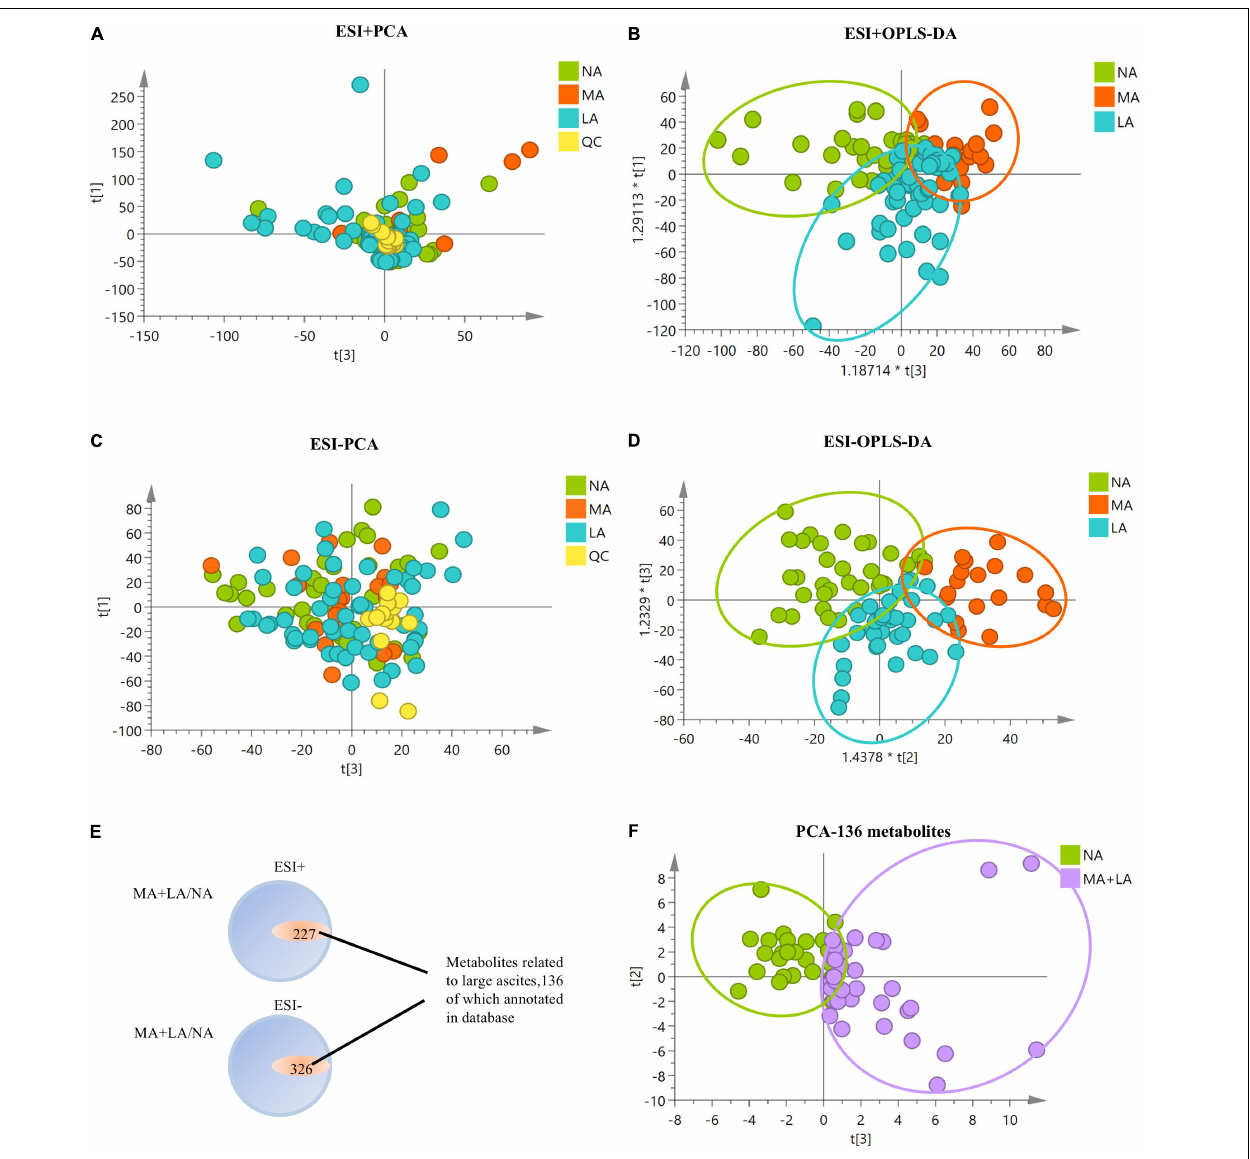
FIGURE 1 | Metabolomics analysis of ALD patients with/without ascites. (A–D) PCA and orthogonal partial least squares discrimination analysis (OPLS-DA) plots with all metabolic variables in NA, MA, and LA patients under positive and negative models of mass spectrometry, respectively. (E) Metabolites with significant differences in MA and LA, in comparison to NA. There are 553 metabolites uniquely associated with ascites, with 136 metabolites annotated in the Human Metabolome Database. (F) PCA plot of MA + LA vs. NA with 136 annotated metabolites related to ascites. The QC samples are clustered together in the PCA plots, indicating stability and technical